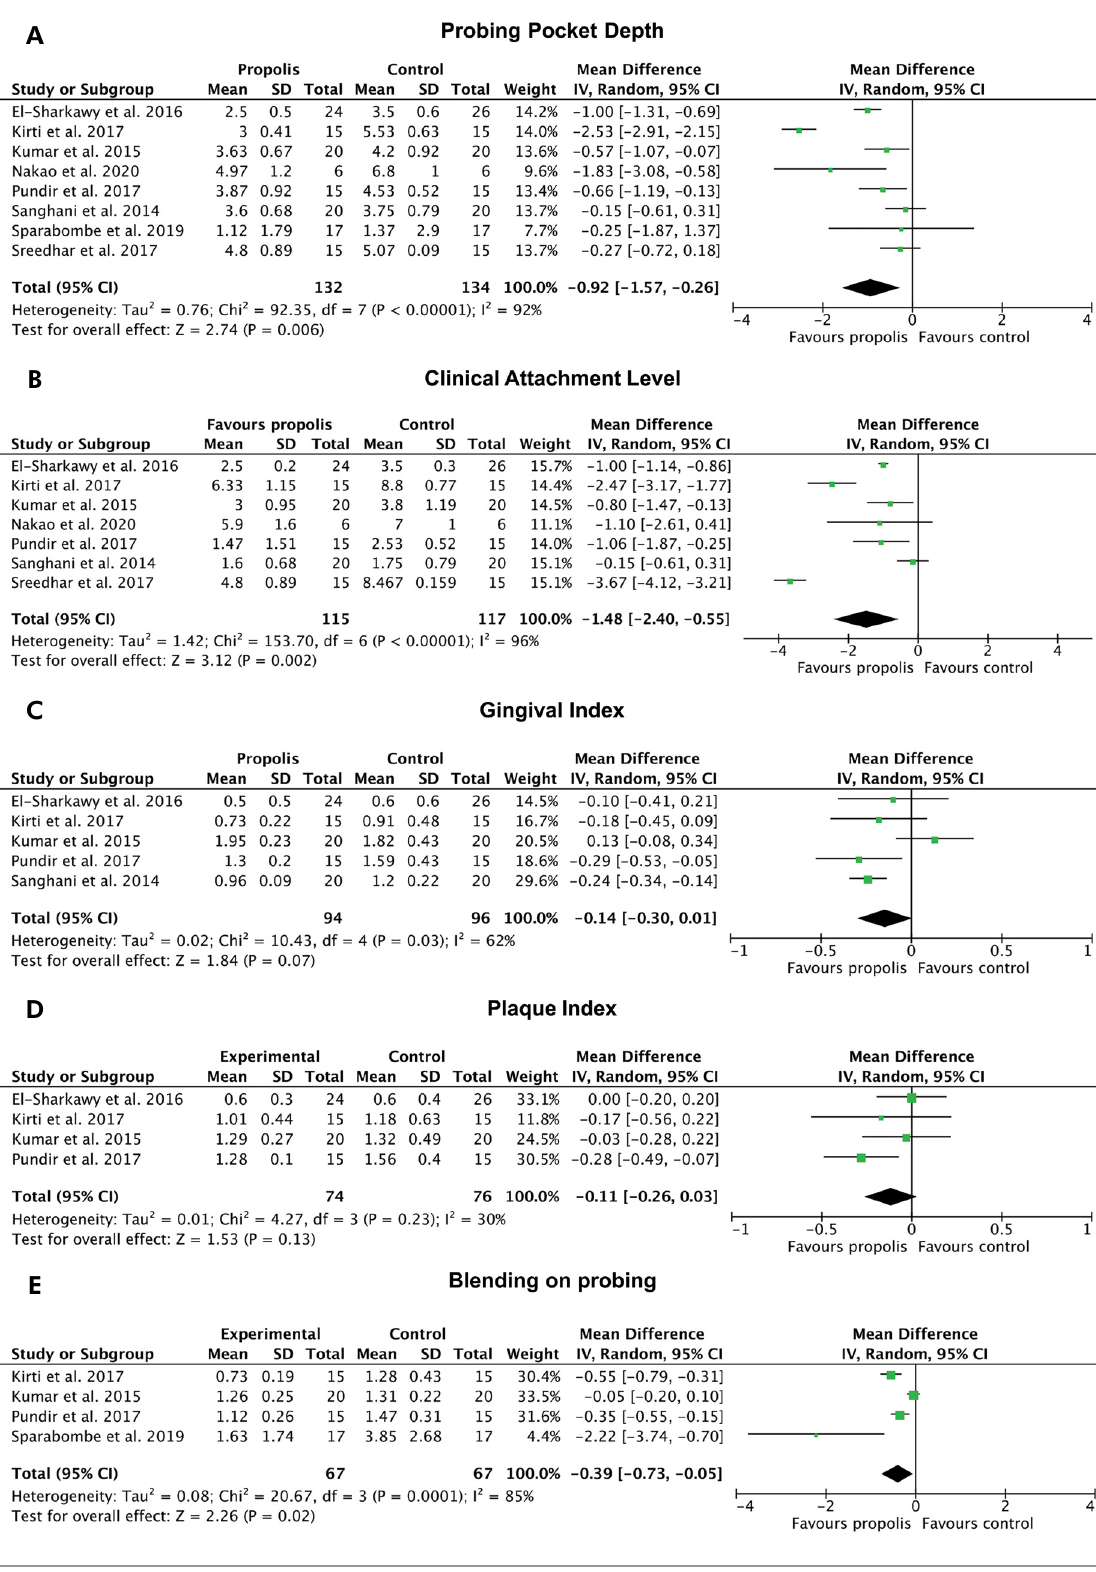
Figure 3. Forest plots for clinical parameters with and without propolis treatment. a) Pocket probing depth; b) Clinical attachment level; c) Gingival index; d) Plaque index and; e) Blending on